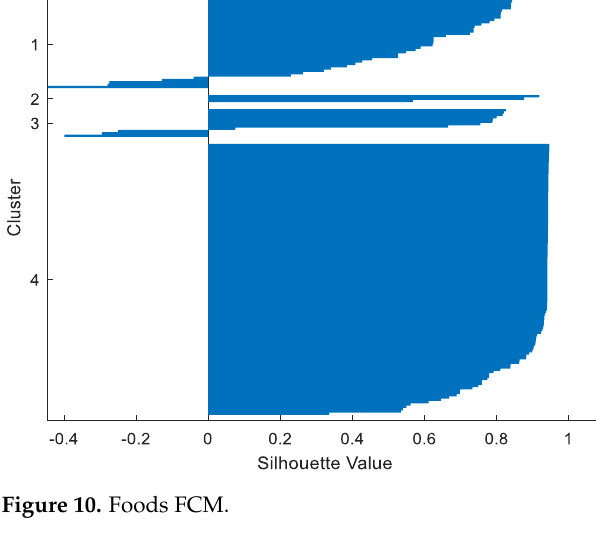
Figure 9. Foods FP-Conv-CM.